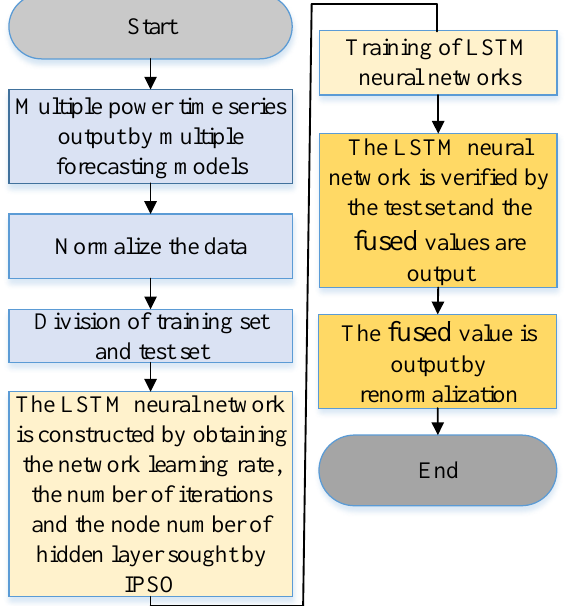
Figure 7. Fusion model based on IPSO – LSTM.